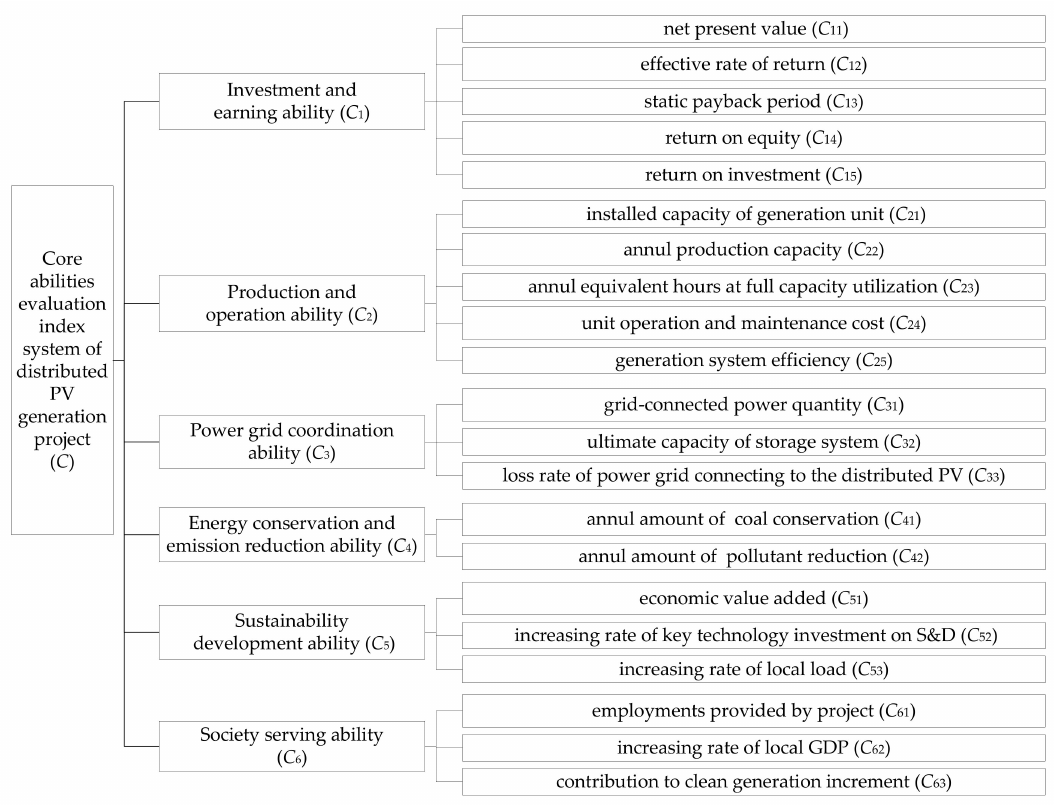
Figure 4. Evaluation index system for core abilities of distributed PV-generation